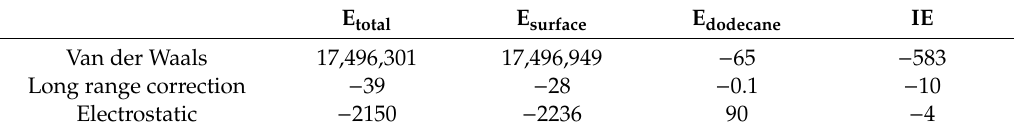
Figure 7. Initial ( a ), final ( b ), and top view ( c ) configurations of the coal-collector (CC) adsorption system (the yellow molecules represent dodecane molecules). Table 2. Interaction energy (IE) between coal and dodecane, kcal / mol.